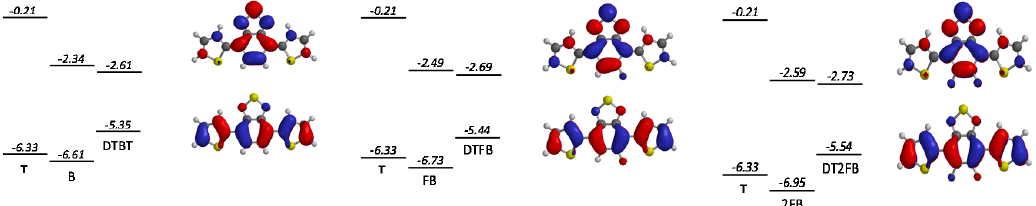
Figure 8. Calculated LUMO and HOMO levels (relative to the vacuum energy level) for the different moieties and the trimers together with the LUMO ( top ) and HOMO ( bottom ) isovalue contour plots. From the left to the right: DTBT, DTFBT and DT2FBT.